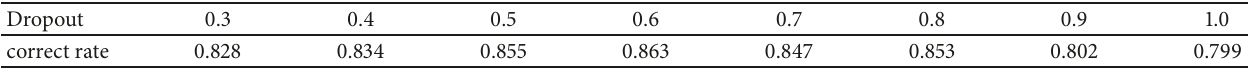
Figure 13: Changes of loss function under different learning rates in training process (1). Table 2: Correct rate of test set under different